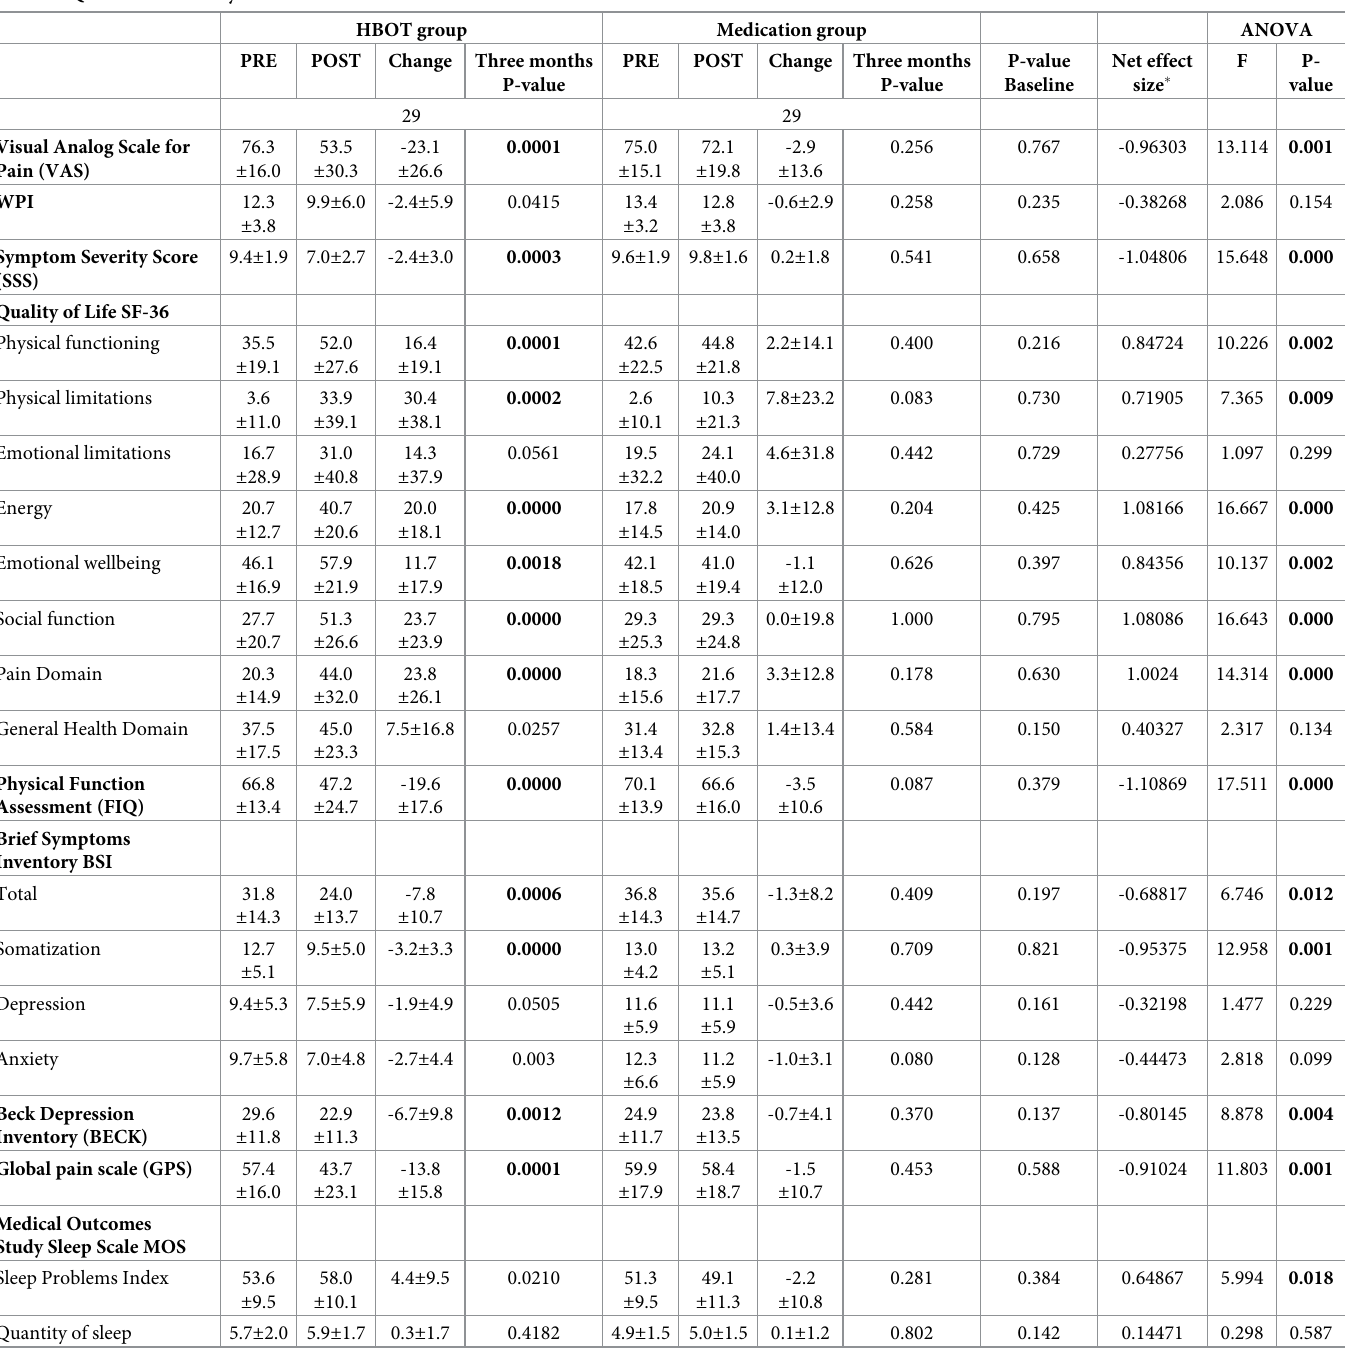
Table 2. Questionnaire